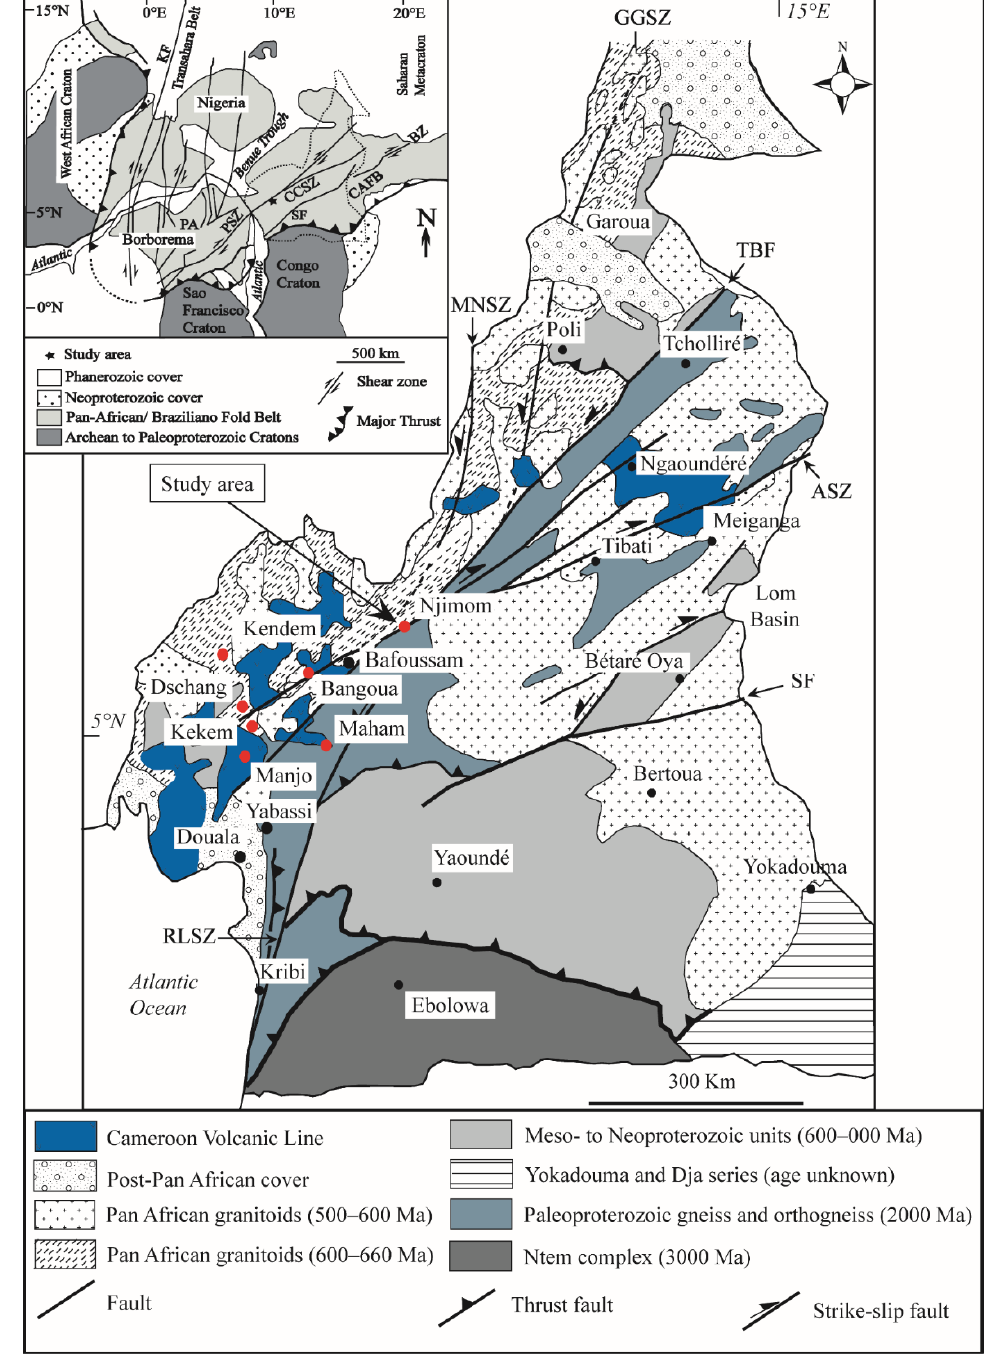
Figure 1. Geological sketch map of Cameroon [17]. CCSZ = Central Cameroon shear zone, SF = Sanaga Fault, TBF = Tcholliré-Banyo fault, RLSZ = Rocher du Loup shear zone, ASZ = Adamawa shear zone, GGSZ = Godé-Gormaya shear zone, MNZ = Mayo Nolti shear zone. The insert is the position of the studied area in pre-drift reconstruction [11]. PA = Patos shear zone, KF = Kandi Fault, PSZ = Pernambuco shear zone. The locations of the mafic dyke swarms (Njimom, Kendem, Dschang, Bangangte, Manjo, Nyos) are also shown.